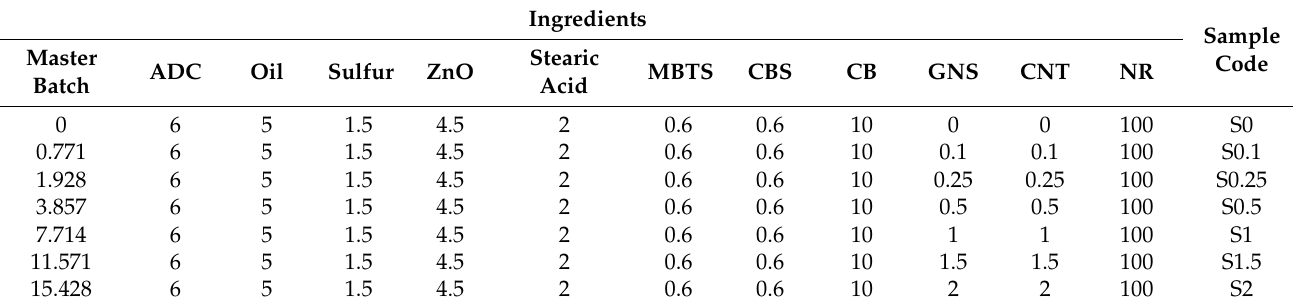
Table 1. Formulation of NR/CNT/GNS nanocomposite